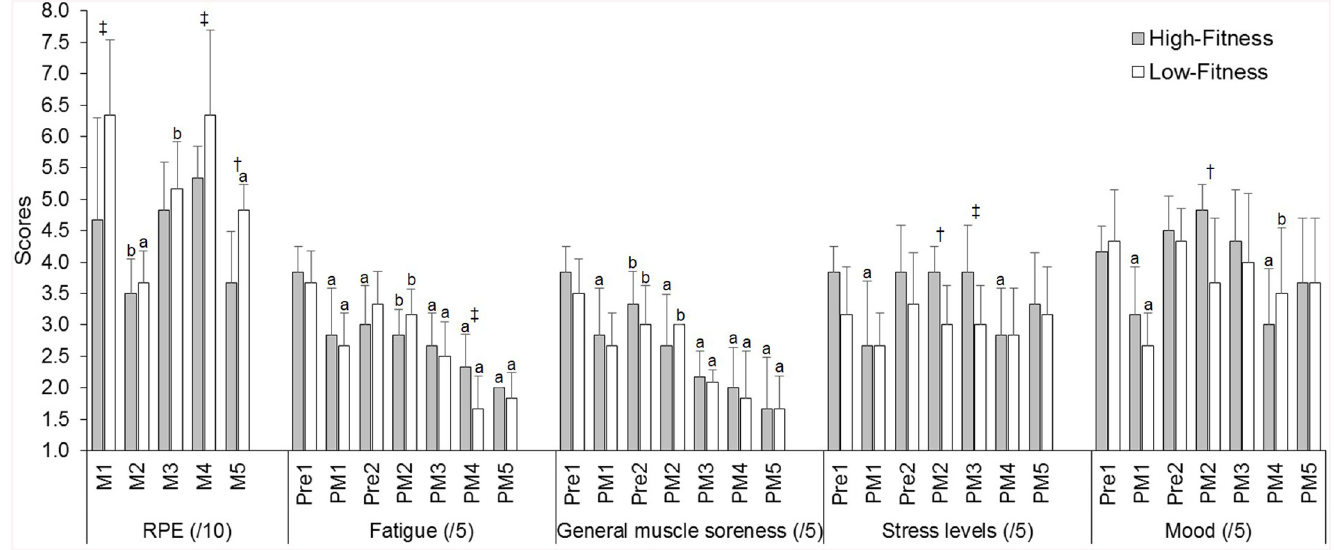
Fig 4. Changes in perceived match-intensity (RPE) and feelings of fatigue, general muscle soreness, stress levels and mood during the tournament. a and b indicate a large and moderate difference compared to match 1, respectively. † and ‡ indicate a large and moderate difference between low- and high-fitness groups,